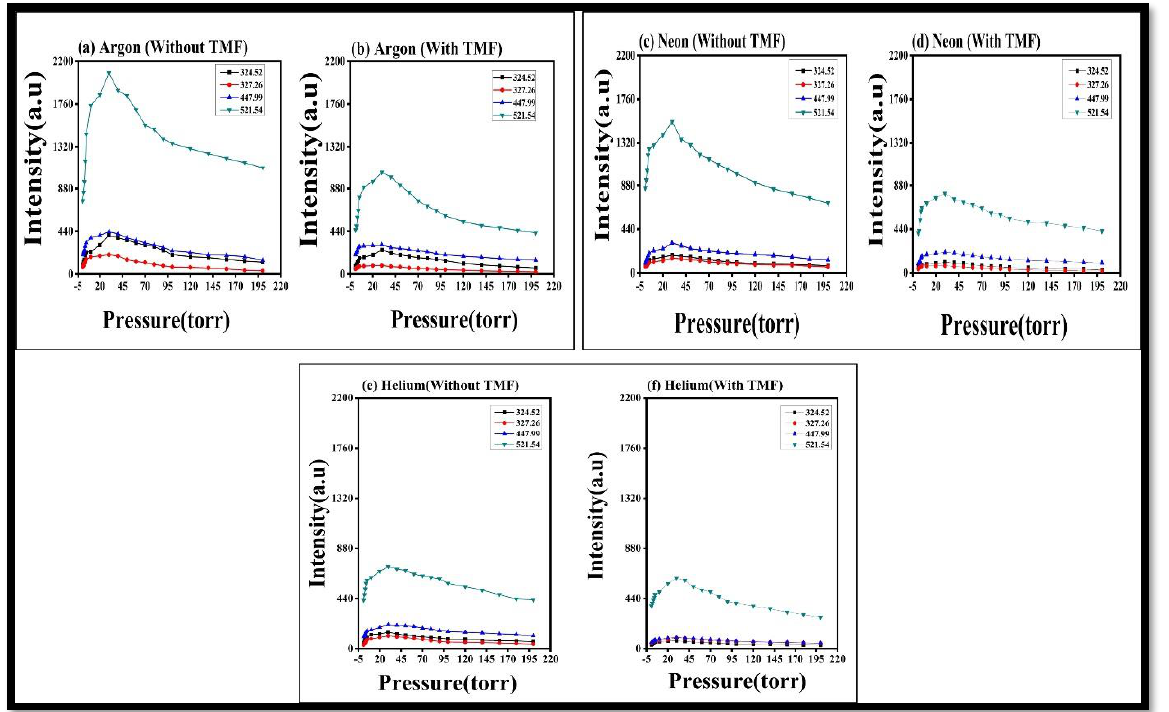
Figure 3. The spectral intensity variation of laser-induced Cu-alloy plasma under several pressure levels of the inert gases Ar ( a , b ), Ne ( c , d ), and He ( e , f ) at 3.8 GW/cm 2 irradiance.